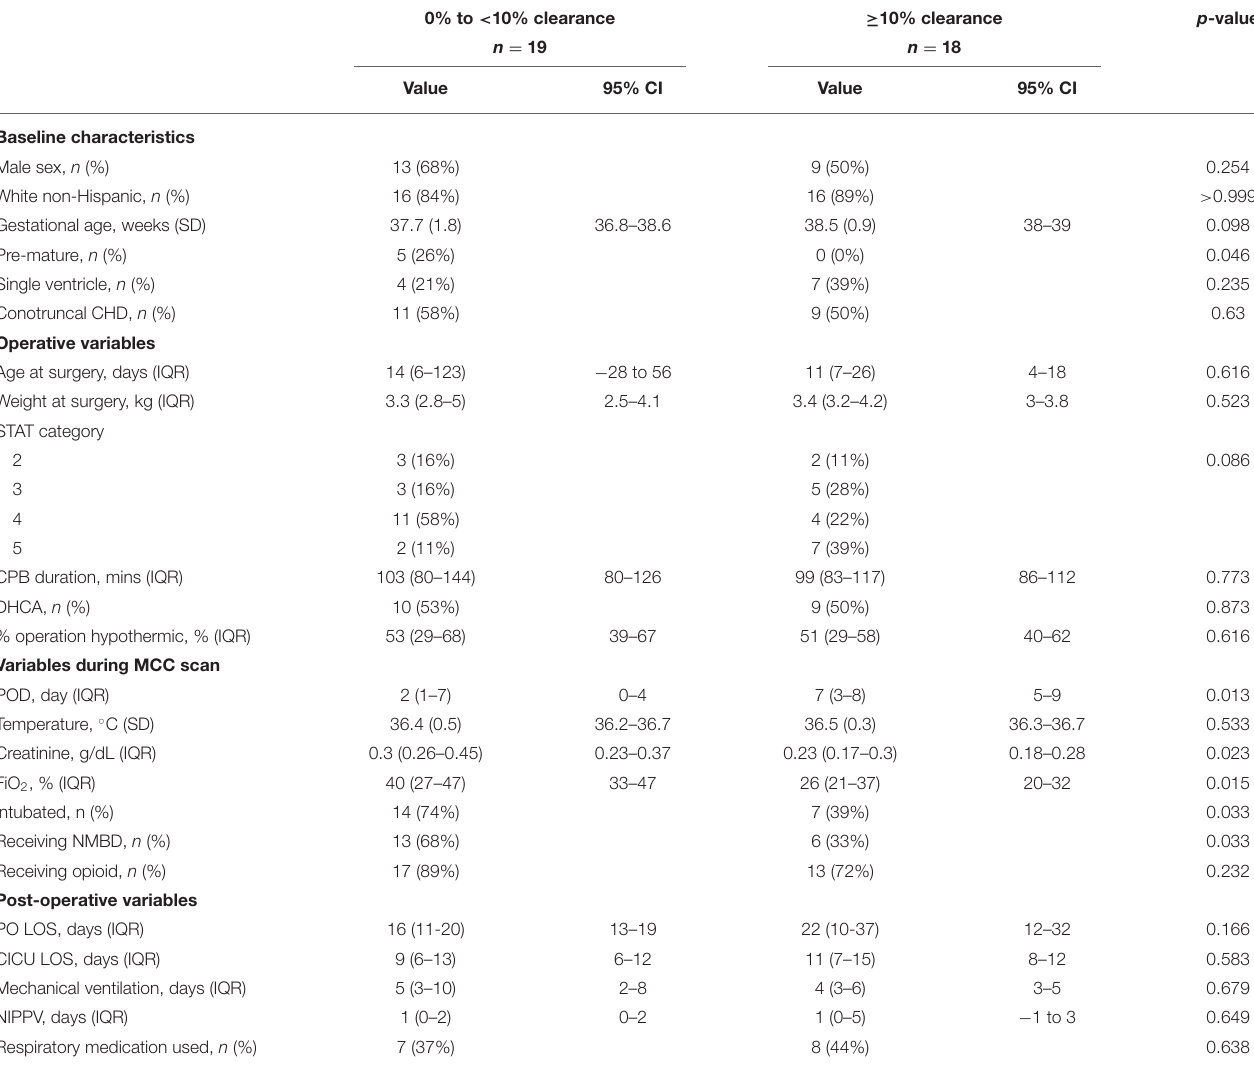
TABLE 1 | Comparison of CHD patients with no/low vs. high post-operative mucociliary